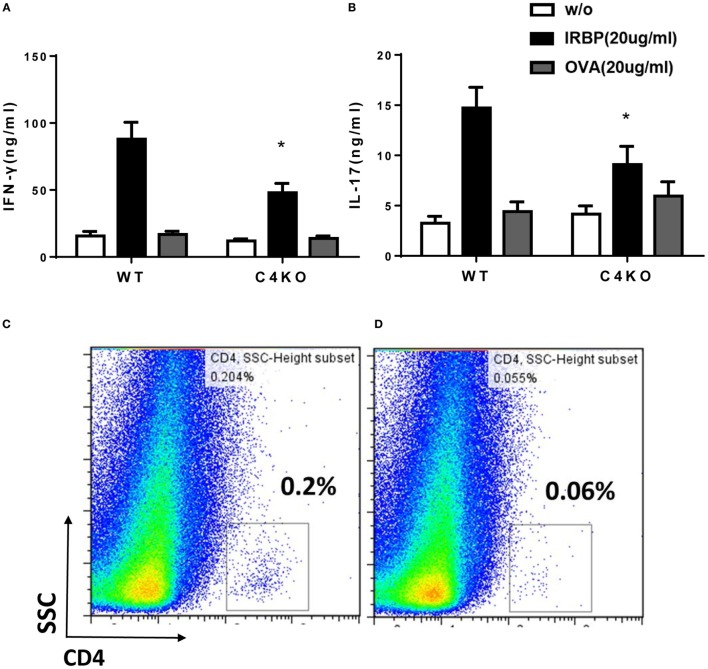
Ex vivo immunological studies of wild-type (WT) and C4 KO mice in experimental autoimmune uveitis (EAU). At day 21 after EAU induction, splenocytes were collected from WT and C4 KO mice and cultured for 72 h without antigen (w/o) or with 20 µg/ml of the immunizing interphotoreceptor retinoid binding protein (IRBP) peptide or a non-relevant peptide (OVA), then, levels of interferon (IFN)γ (A) and IL-17 (B) were measured by ELISA (n = 22 in each group) mean ± SEM; *p < 0.05 by one-way ANOVA. On the same day, eyes were collected from five mice in each group and single cell suspensions prepared and pooled, then the percentage of CD4+ T cells in the infiltrating cells in the eye of WT (C) and C4 KO (D) mice was analyzed by flow cytometry.